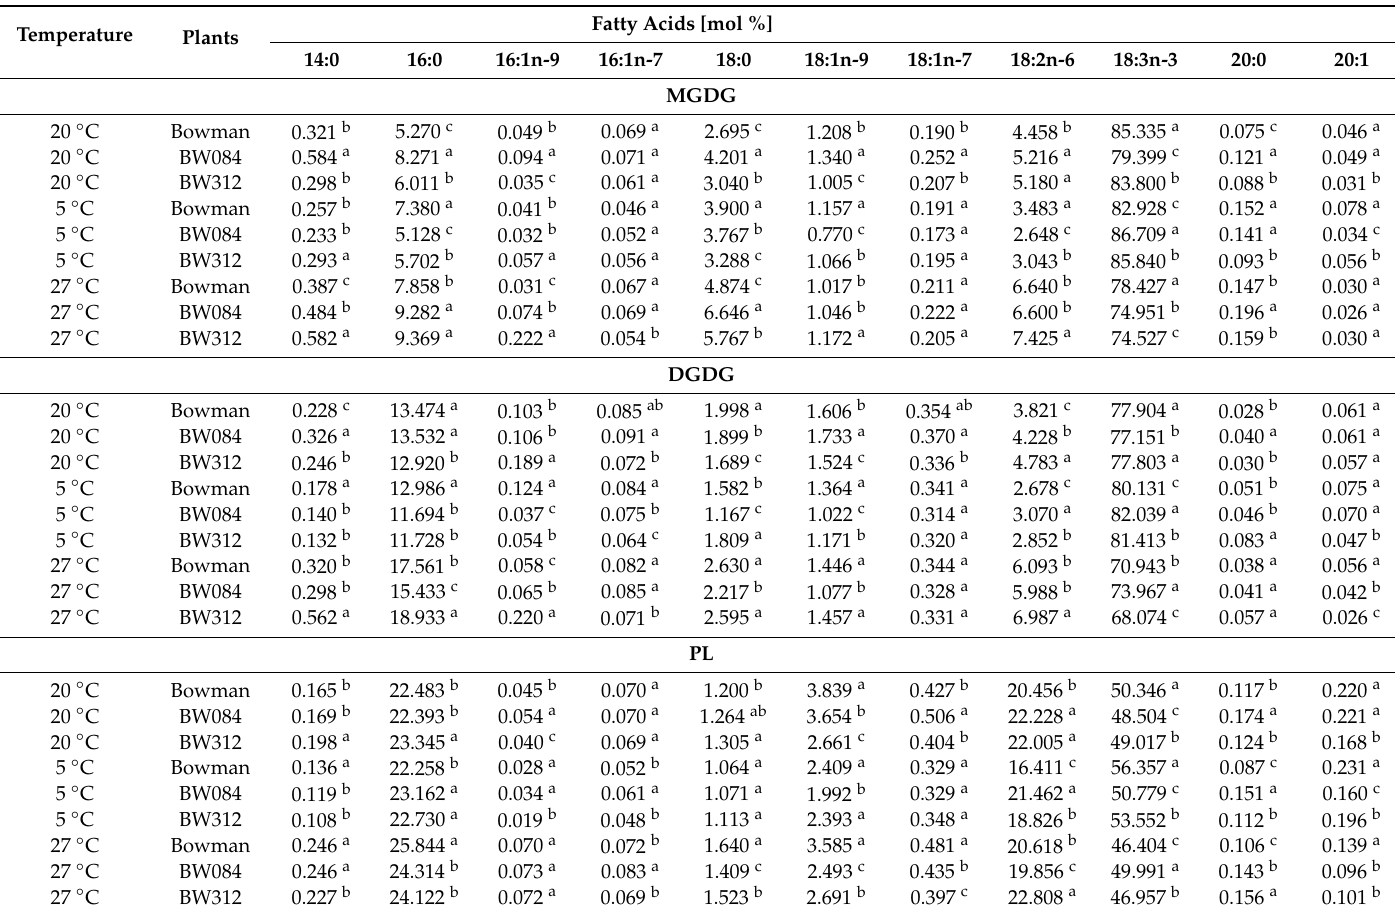
Table 1. Composition of the fatty acids from the three classes of lipids (MGDG, DGDG, PL) that were isolated from the barley WT Bowman and its BW084 and BW312 mutants cultured at 20 ◦ C and then acclimated at 5 ◦ C or 27 ◦ C. Any significant di ff erences between WT Bowman and its mutants (Duncan test, p ≤ 0.05) for each temperature, lipid fraction, and fatty acid (separately) are indicated by di ff erent